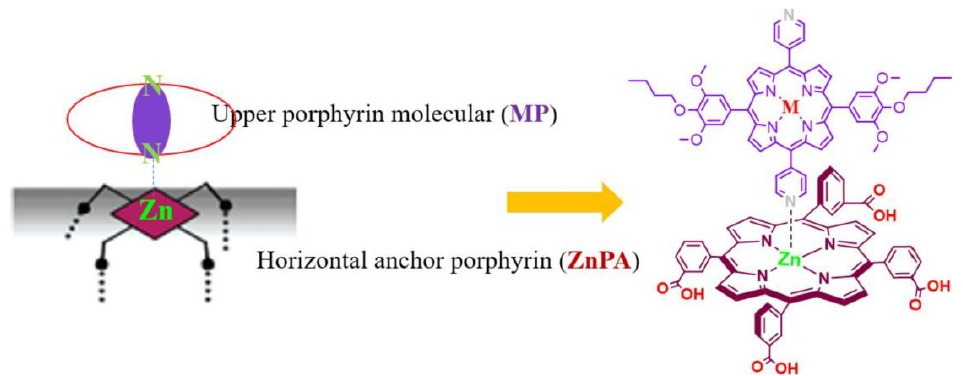
Figure 6. Detailed building approach of the assembly of a metalloporphyrin (MP) and an anchoring Zn porphyrin (ZnPA) on a TiO 2 electrode surface. Reproduced from reference [58] with permission from Elsevier, copyright 2022.